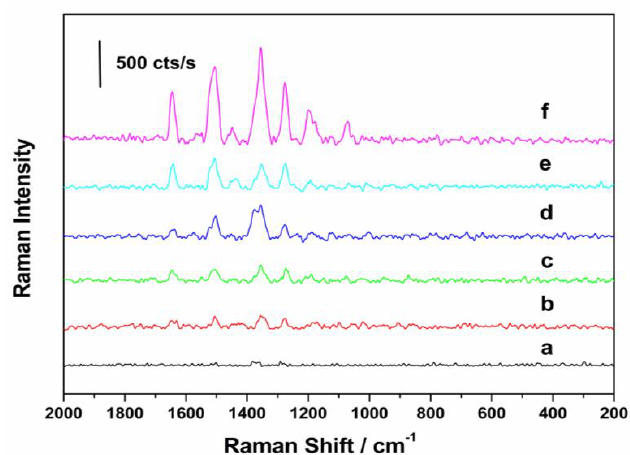
Figure 9. Raman spectra of [Fe 3 O 4 /Au–AOA ••• melamine ••• AOA–RhB] in milk at melamine concentration of 0 µg/mL ( a ), 2.0 µg/mL ( b ), 2.5 µg/mL ( c ), 5.0 µg/mL ( d ), 10.0 µg/Ml ( e ), and